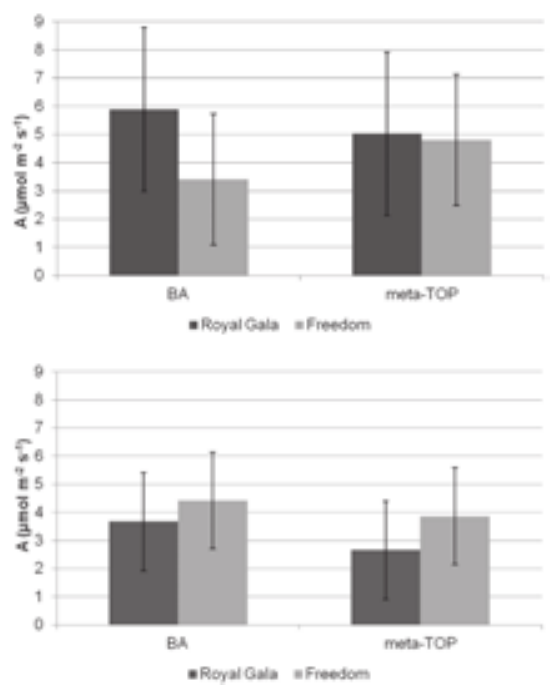
Figure 2. Effects of different cytokinins and apple cultivars on rate of CO exchange (A) at (A) 2.0 µM and (B) 6.0 µM cytokinin supply. *: means significant (P ≤ 0.05) differences between the apple scion cultivars (‘Royal Gala’ and ‘Freedom’) at the same cytokinin type; ▼ : means significant (P ≤ 0.05) differences between the cytokinin types (BA and meta-TOP) in the same scion cultivar